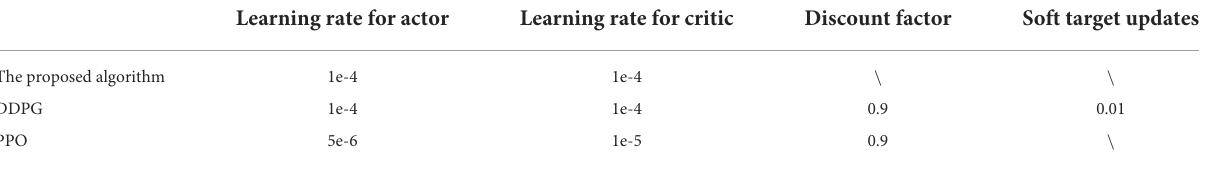
TABLE 4 The hyperparameters of the discussed deep RL